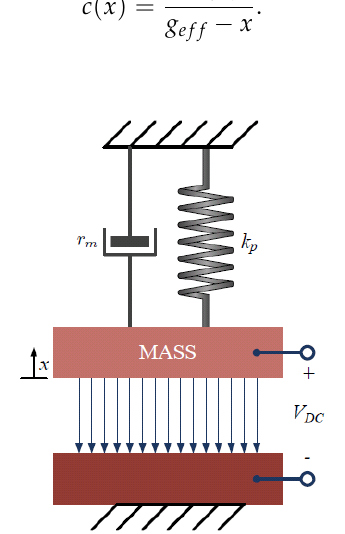
Figure 2. Simplified mass-spring-damper CMUT